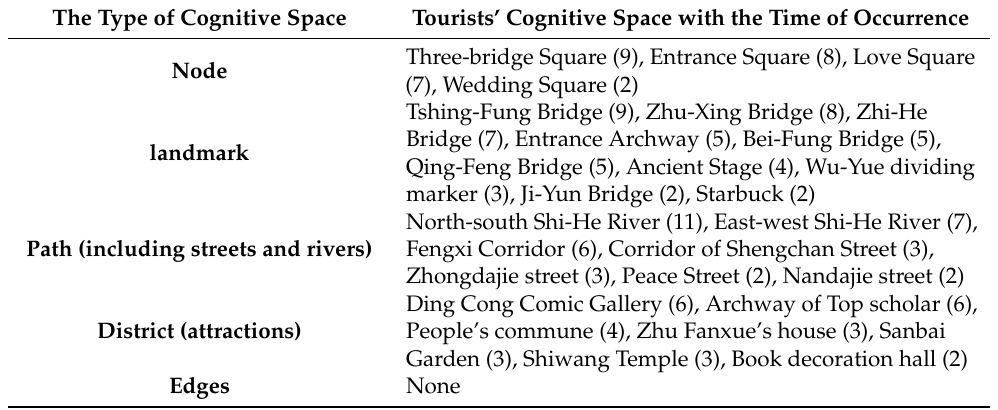
Table 2. The categories of Fengjing Ancient Town tourists’ cognitive space based on the tourist memory map (source: authors).